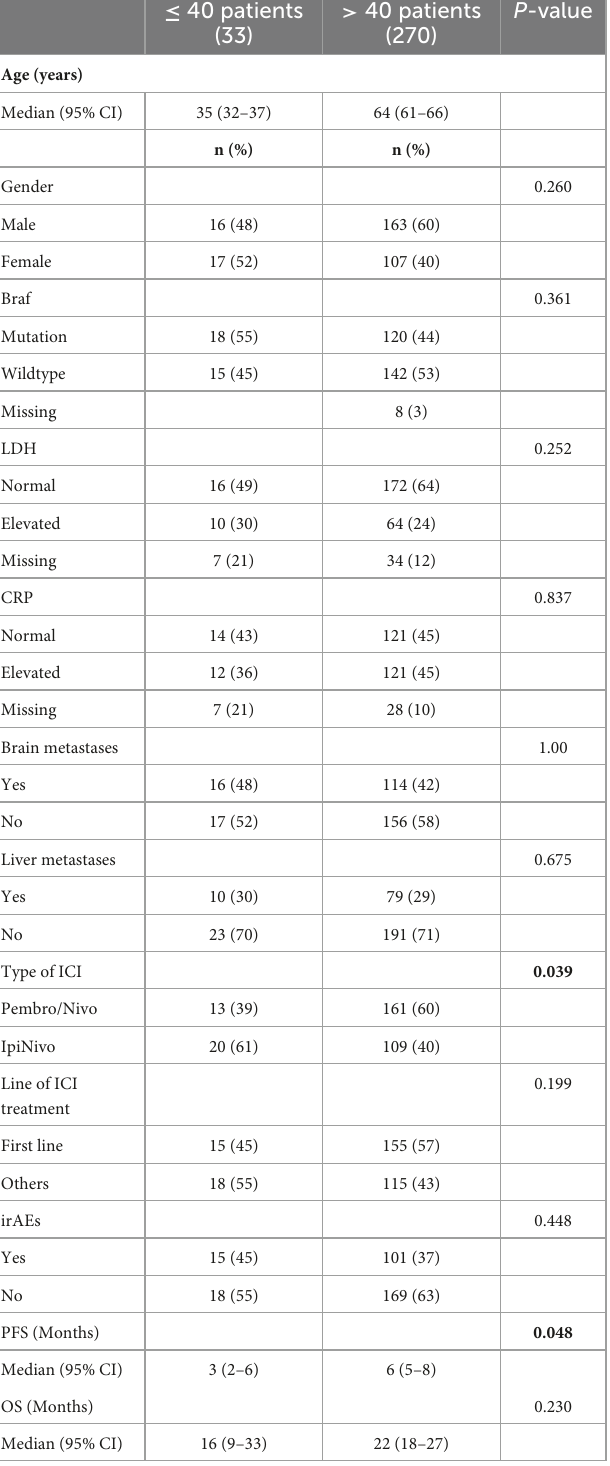
TABLE 1 Patient characteristics and clinical outcomes based on